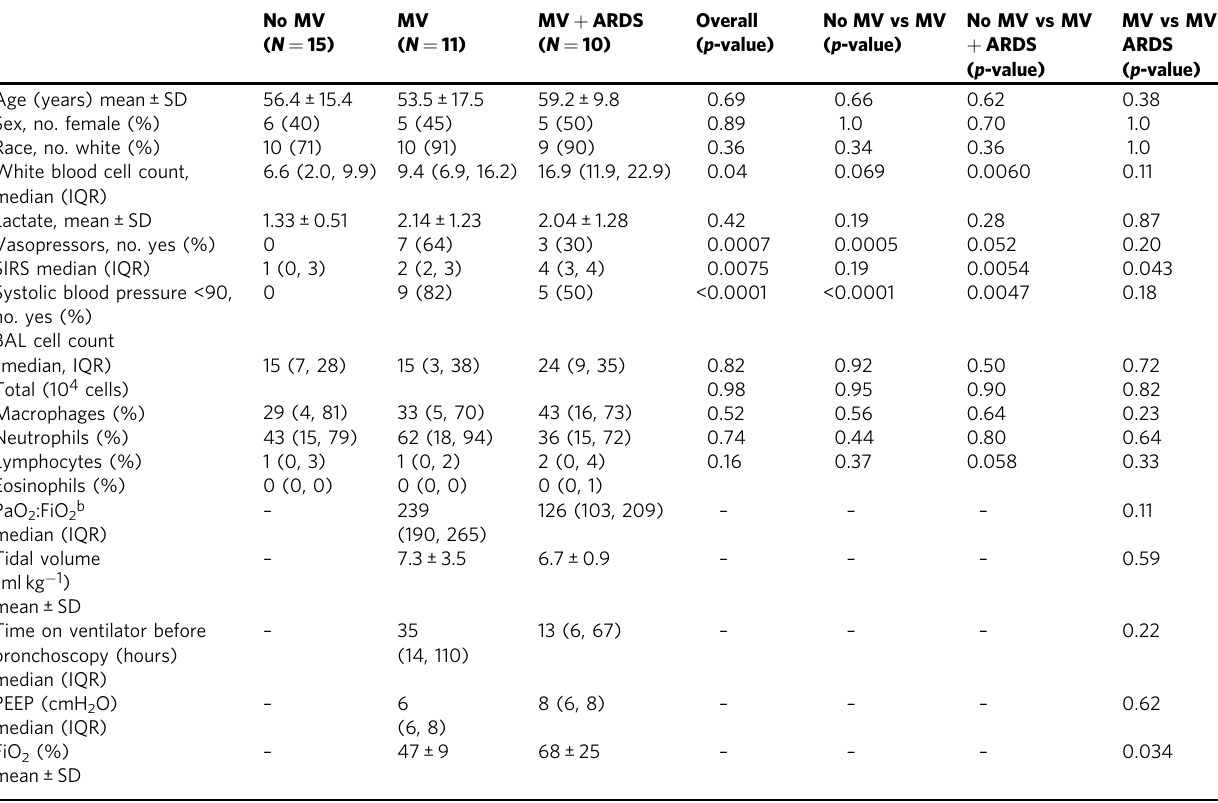
Table 1 Patient characteristics and group analysis from Intensive Care Unit cohort a